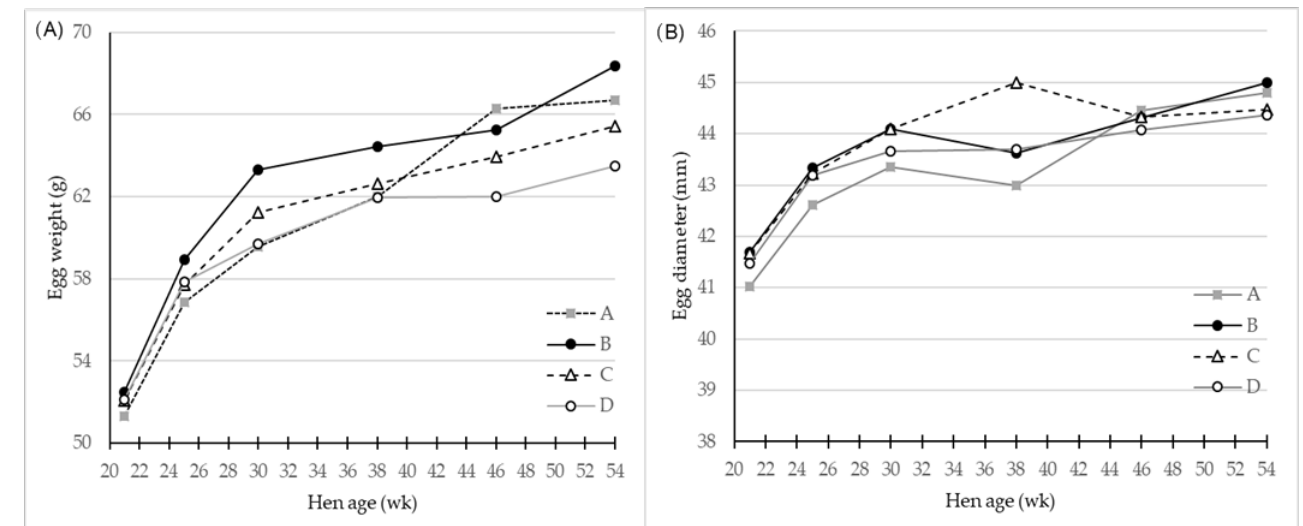
Figure 1. LS-means of ( A ) Egg weight (g) and ( B ) egg diameter (mm) for eggs of four different hen genotypes A, B, C, and D as differentiated by hen age (week), n = 30 for genotype A and 45 for genotypes B, C and D. There was a significant ( p < 0.001) interaction effect of genotype and hen age on both parameters.